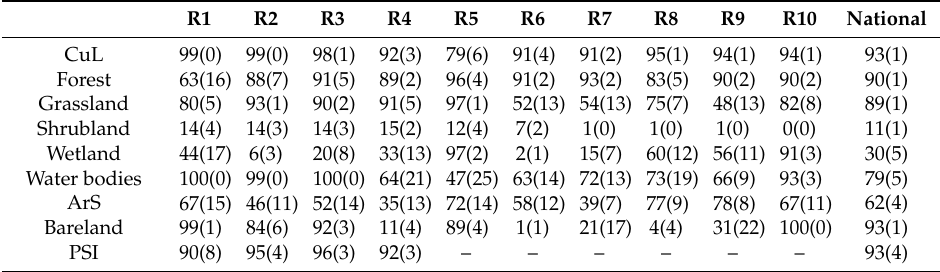
Table 6. Regional producer’s accuracies for nine land cover classes with standard errors (SE) in parentheses. Agreement is defined as a match between the map class and either the primary or alternate reference class (see Table 5 for meanings of CuL, ArS, PSI, and –, and Column “National” represents countrywide producer’s